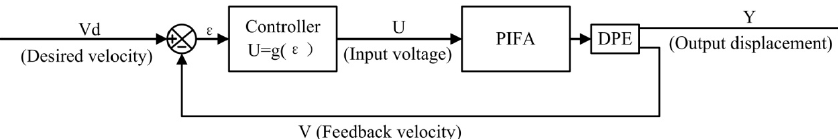
Figure 13. Velocity feedback